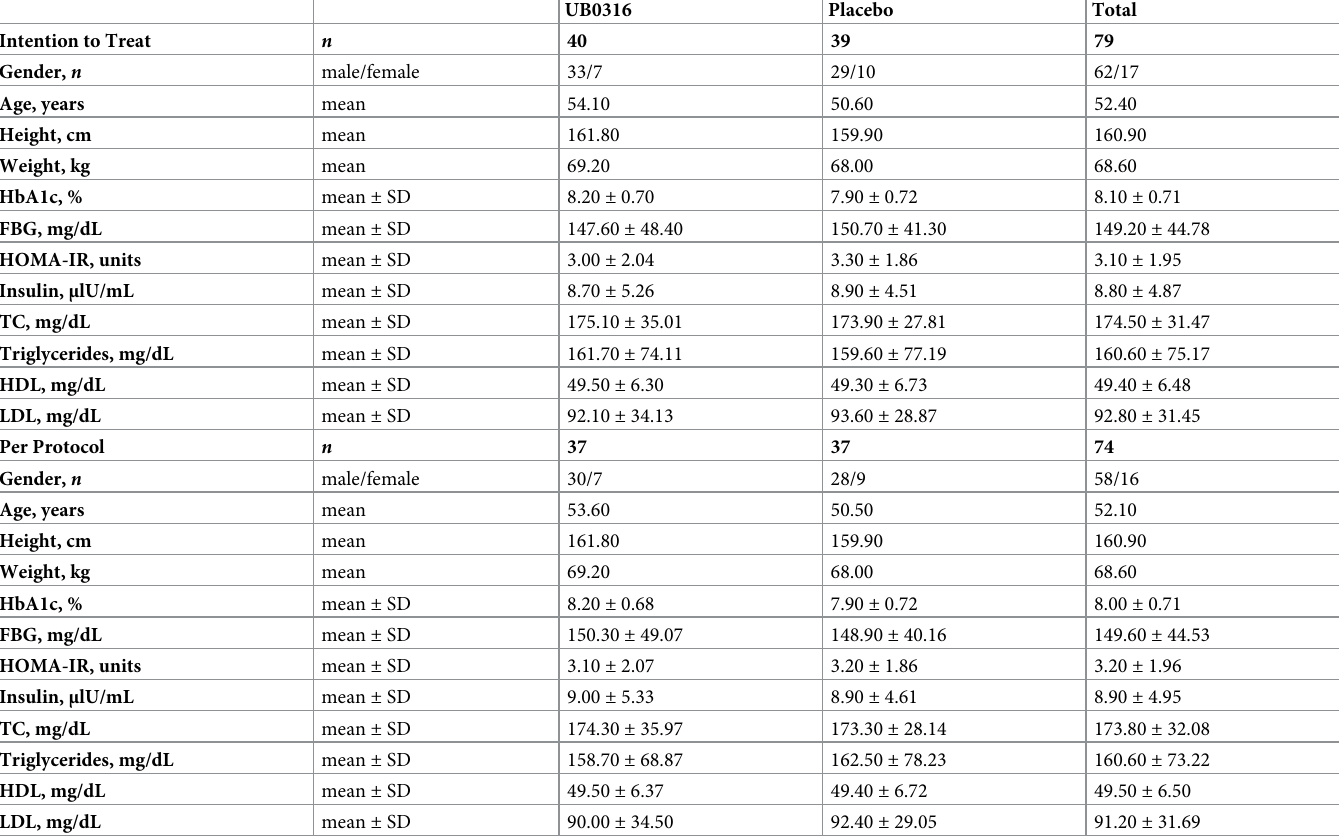
Table 1. Baseline characteristics of participants in each group.